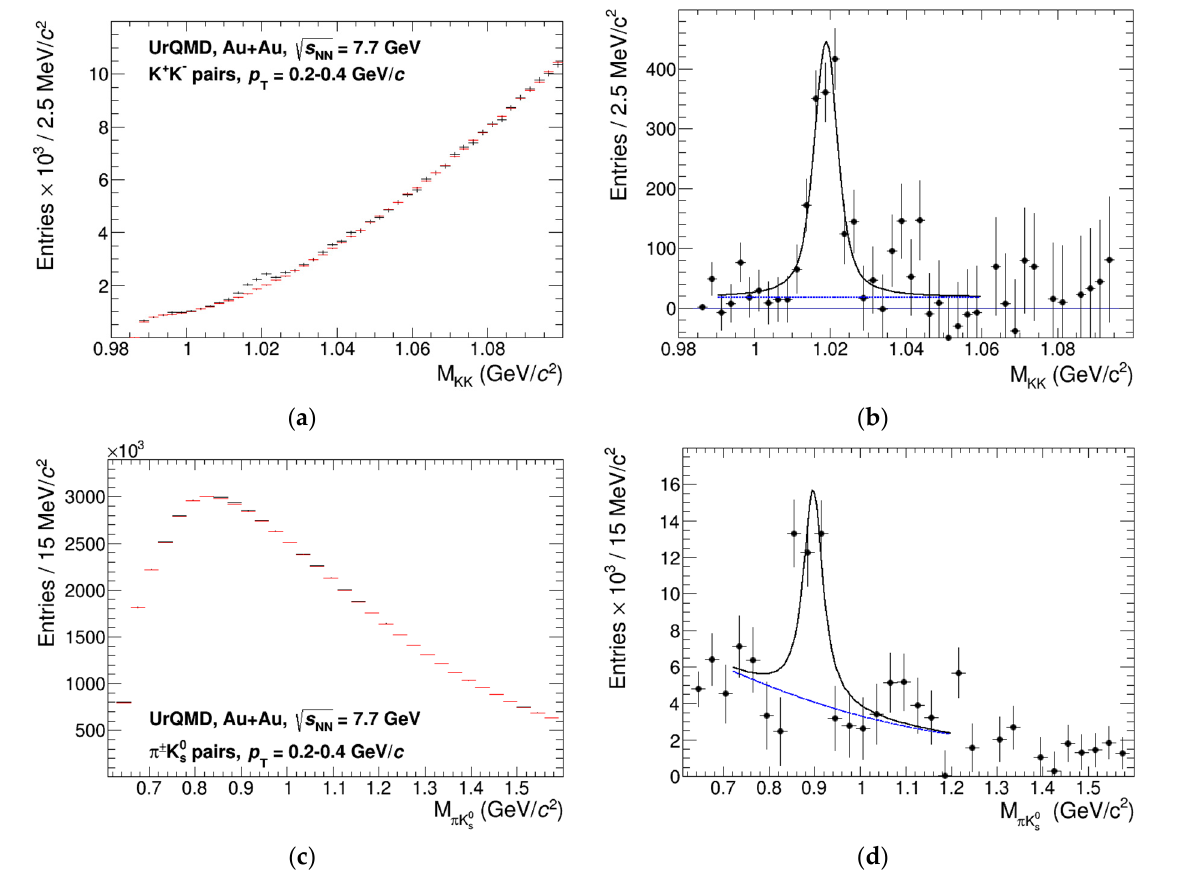
Figure 1. The invariant mass distributions accumulated for K + K − ( a , b ) and π ± K 0 s ( c , d ) pairs in 5 × 10 6 Au + Au collisions at √ s NN = 7.7 GeV in the momentum range 0.2–0.4 GeV/ c . The distributions are shown before ( a , c ) and after ( b , d ) the mixed-event background subtraction. The plots ( a , c ) show the foreground (black) and the mixed-event (red) invariant mass distributions.